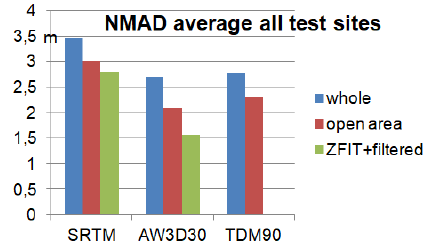
Figure 23. Average NMAD of all test sites with test site Mountain for terrain inclination below